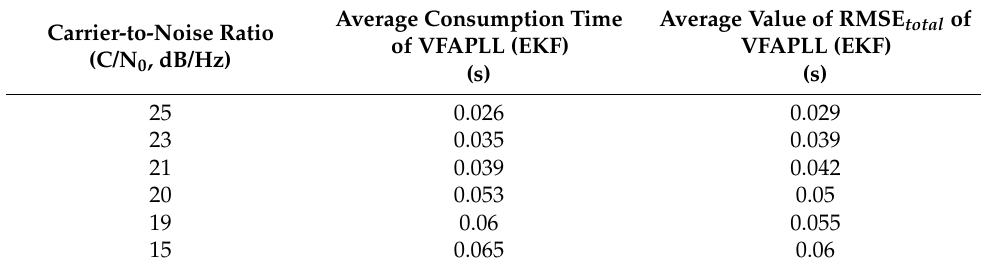
Table 2. The average consumption time and Average value of RMSE total of VFAPLL (EKF) when CNR is 15, 19, 20, 21, 23, and 25